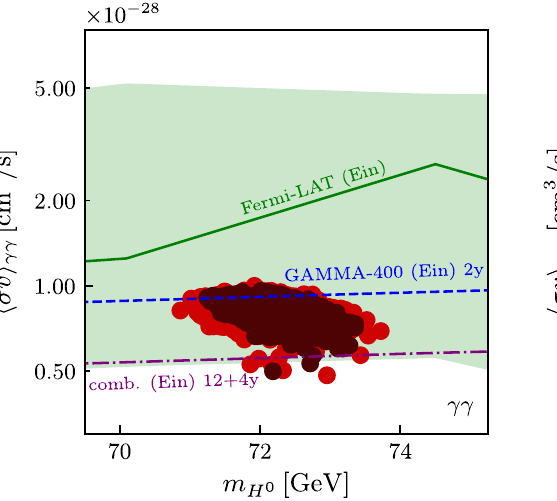
Fig. 2 Crosssectionfortheloop-induceddark-matterannihilationinto γγ (left panel) and γ Z (right panel) for the allowed IDM parameter points explaining all of dark matter ( Ω h 2 = 0 . 12) in the range 70– 75GeV. Parameter points in the 1 and 2 σ regions are drawn in dark brown and red, respectively. The green solid curve denotes the Fermi- LAT limit for the Einasto profile. The lower and upper boundary of the